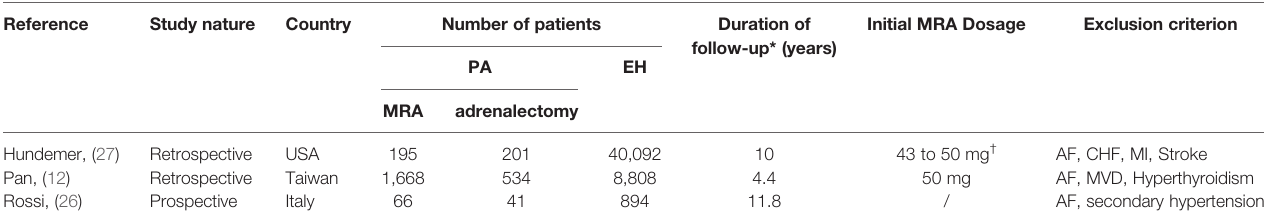
TABLE 1 | Characteristics of the studies meeting the inclusion criteria.